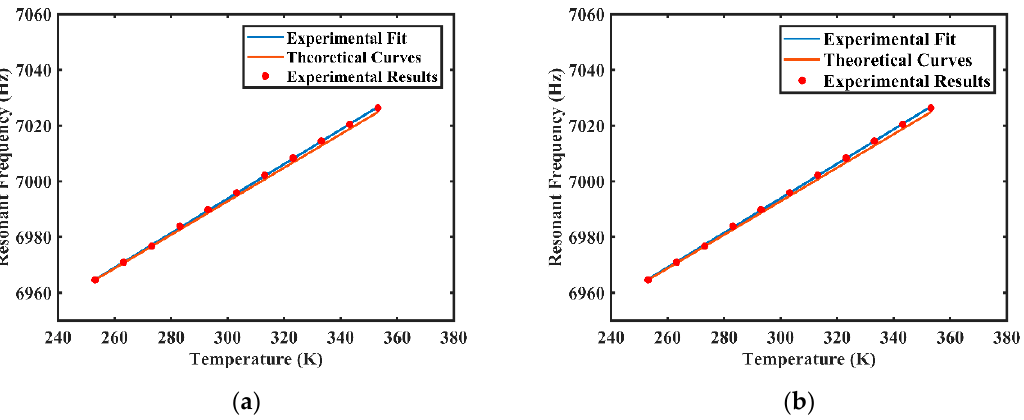
Figure 6. The experimental results of resonant frequency varying with temperature at the temperature range from 253.15 K to 353.15 K: ( a ) results from the heating process; ( b ) results from the cooling process.